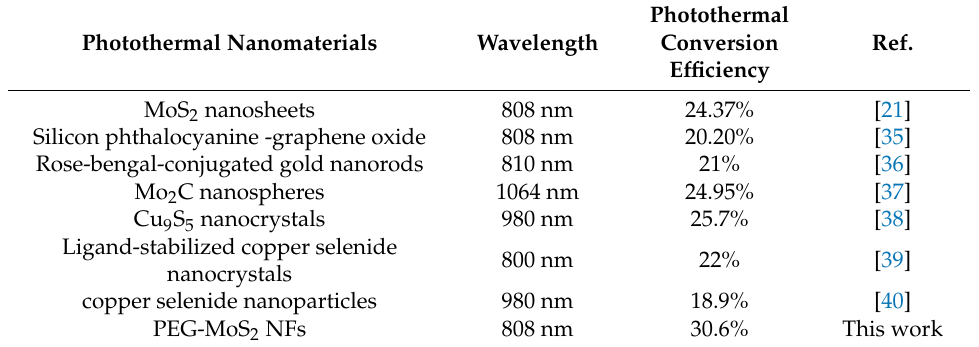
Table 1. The photothermal conversion efficiency of different photothermal